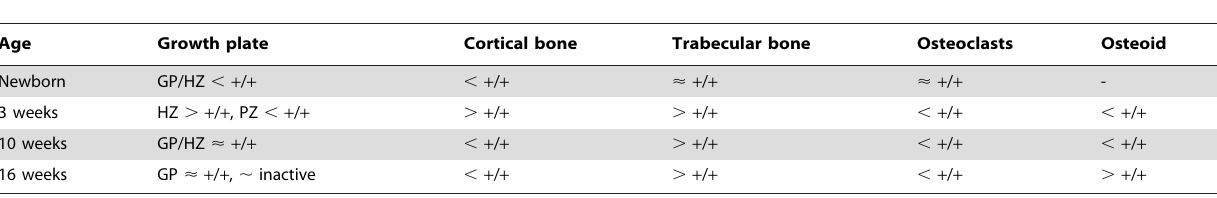
Table 2. Impact of the absence of BSP on postnatal development of the skeleton.